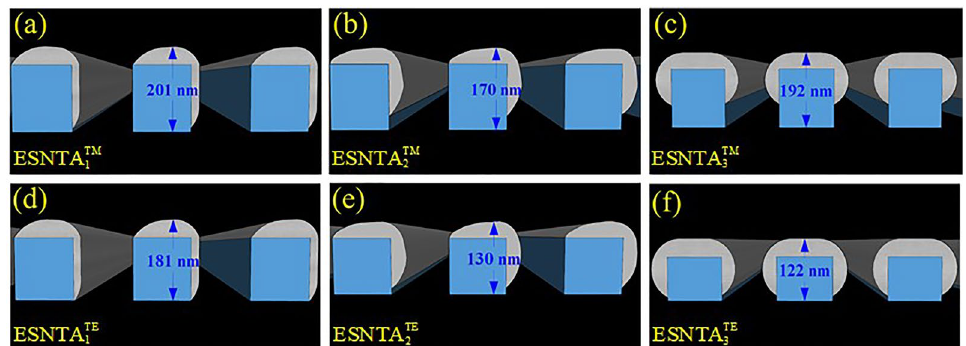
Figure 7. Schematic-drawings of ( a ) ESNTA 1TM , ( b ) ESNTA 2TM , ( c ) ESNTA 3TM , ( d ) ESNTA 1TE , ( e ) ESNTA 2TE , and ( f ) ESNTA 3TE in free space.